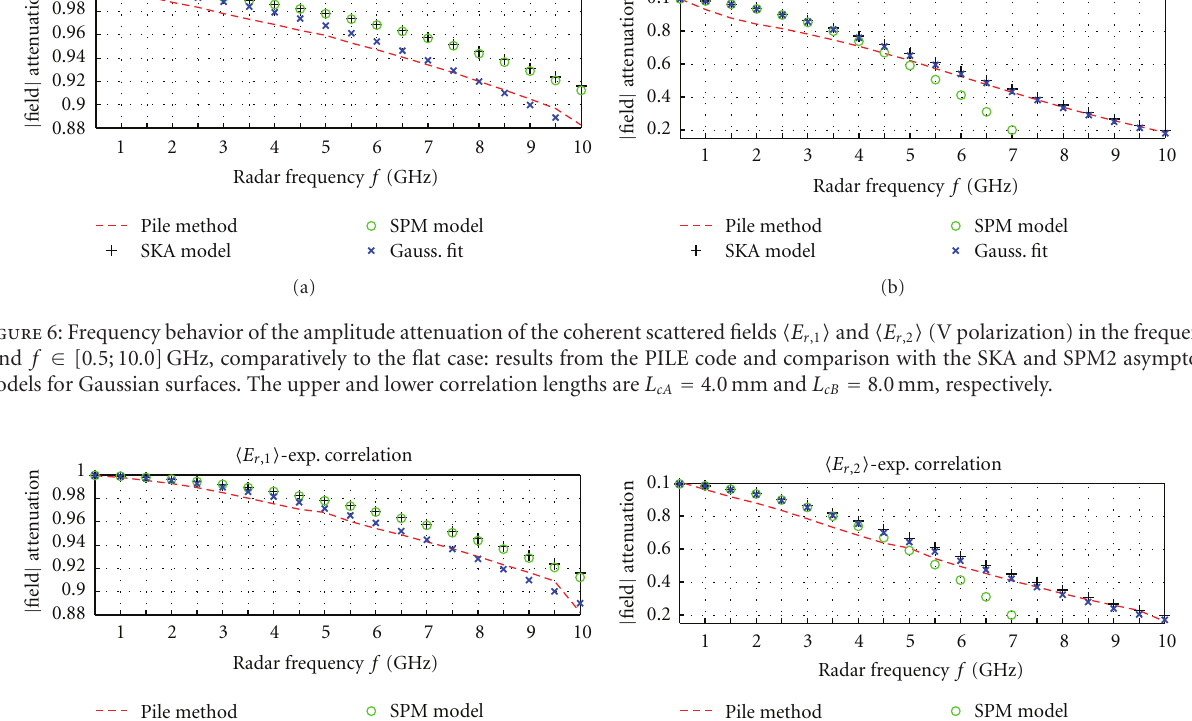
0.880.90.920.940.960.98